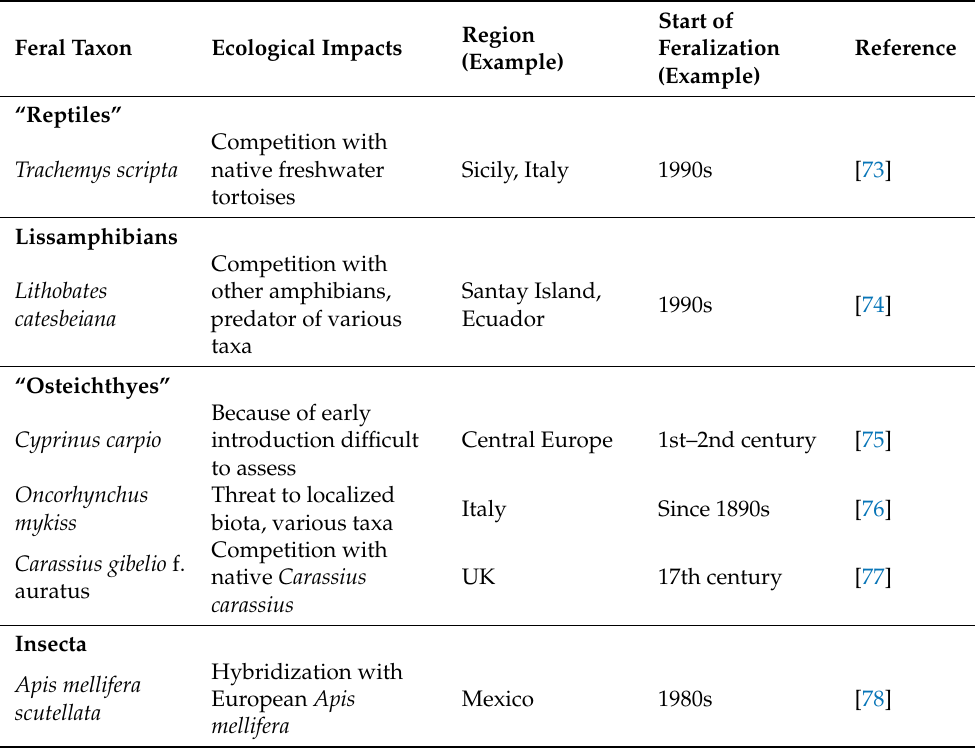
Table 3. Selected examples of feralization events of other taxa and their ecological implications. Taxon names in quotation marks indicate paraphyla or historically used systematic